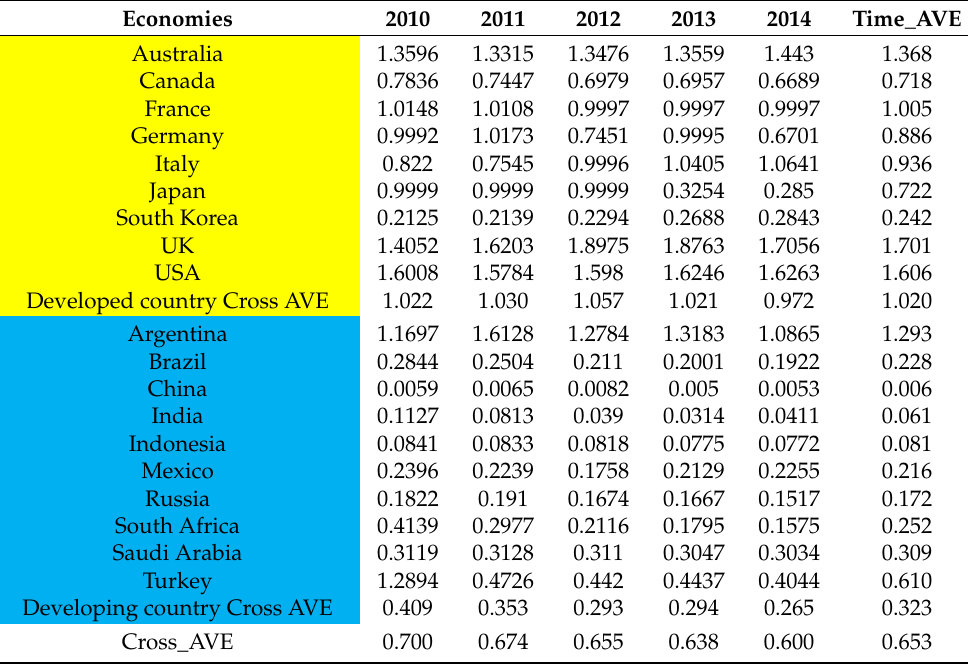
Figure 1. Descriptive statistics of input and output from 2010 to 2014. Table 2. Energy efficiencies of G20